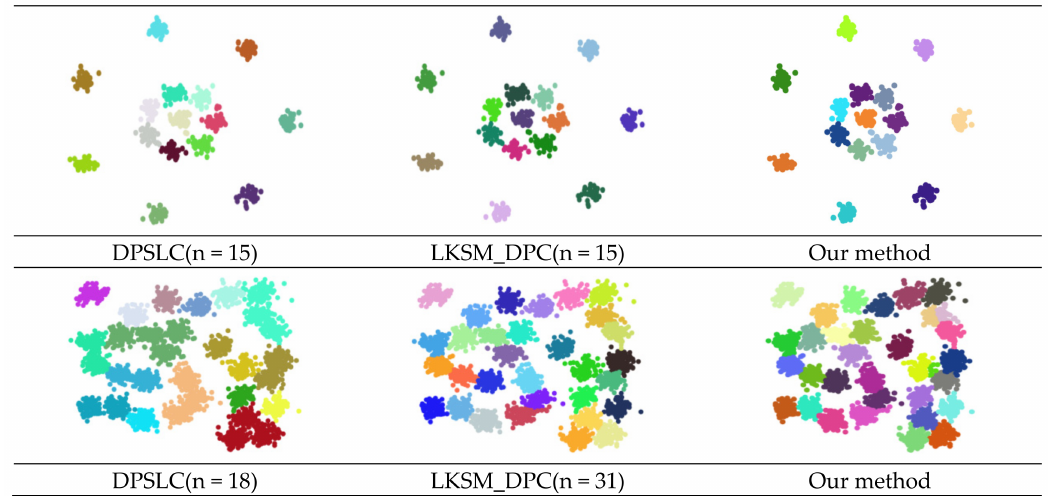
Figure 14. Clustering results by DPSLC, LKSM_DPC and proposed method of dataset